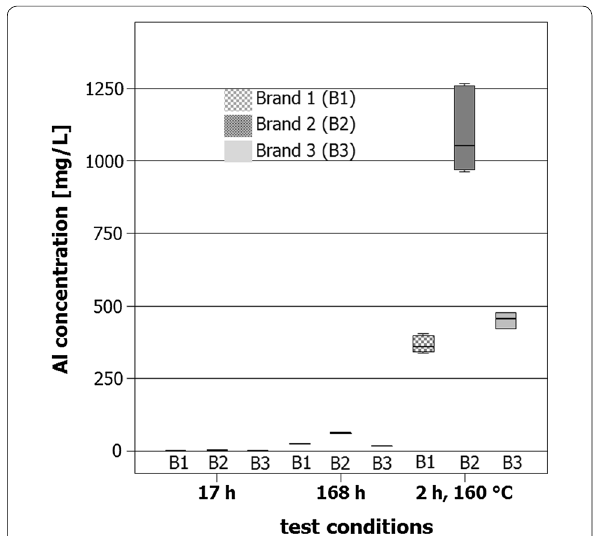
Fig. 6 Box plots of the aluminum concentrations in citric acid sam‑ ples after contact with brands 1, 2, and 3 of aluminum pans after 17 h